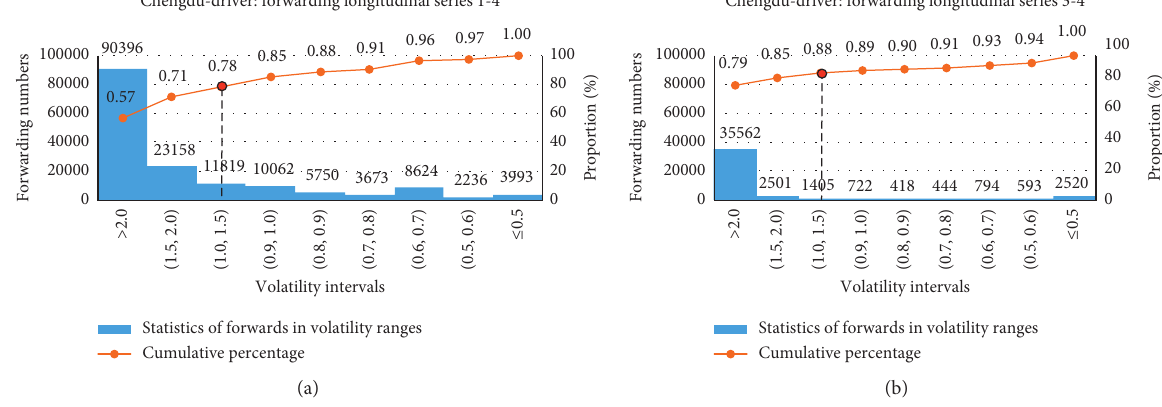
Figure 6: Stationary sequence recognition result on the event Chengdu-Driver: (a) forwarding longitudinal series 1–4; (b) forwarding longitudinal series 3–4. The sum of the forwarding ratios with volatility values greater than 1 equals 0.78 which is shown in (a). The score indicates the nonstationary characteristic of the event. The instability is mainly caused by the forwarding behavior of levels 3 and 4 according to the value 0.88 shown in